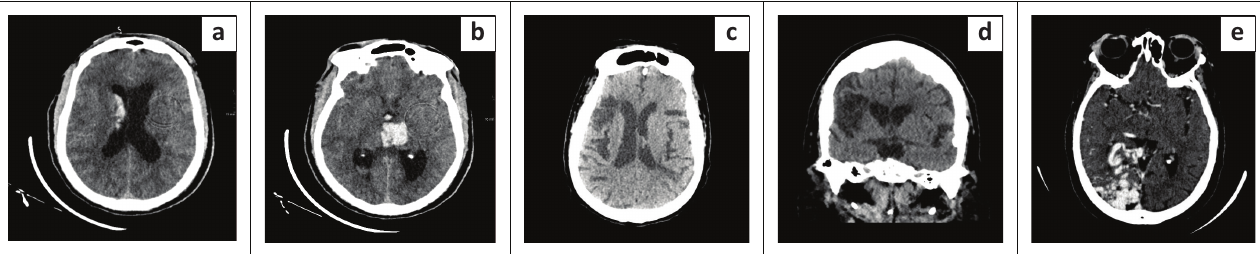
FIGURE 1 : Vascular pathology as a cause of adult-onset seizures. (a and b) Hypertensive intraparenchymal haemorrhage in a 56-year-old male with newly diagnosed hypertension. Axial non-enhanced CT (NECT): Left thalamic haemorrhage with minimal surrounding oedema. Associated intraventricular blood. (c and d) Chronic right middle cerebral artery territory infarction in an adult patient with index episode of seizures. Axial and coronal NECT: Right MCA territory wedge-shaped hypodensity with mild right lateral ventricular ex vacuo dilatation. (e) Right occipital lobe arteriovenous malformation in a 53-year-old female with no background medical history. Axial contrast enhanced CT (CECT): ‘Bag of worms’ appearance of draining and feeding vessels in the right occipital lobe.